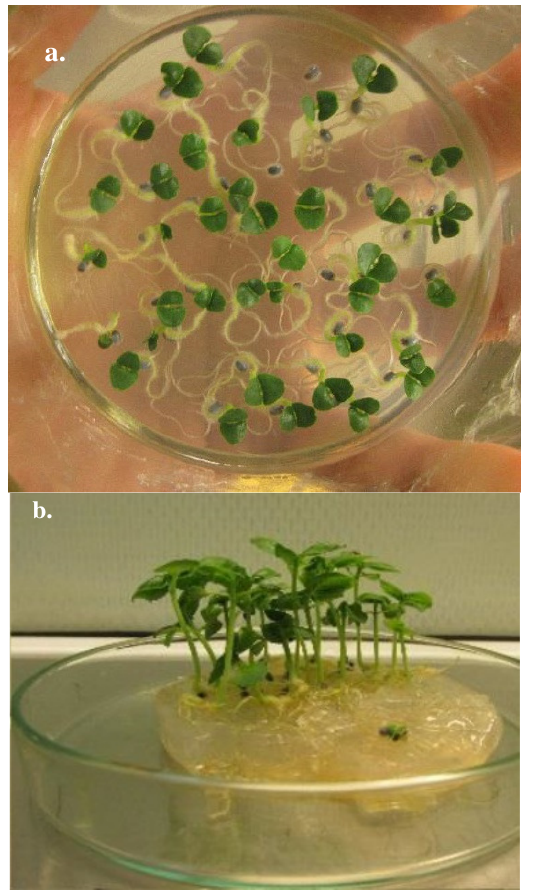
Fig. 1. In vitro germination of basil ( Ocimum basilicum